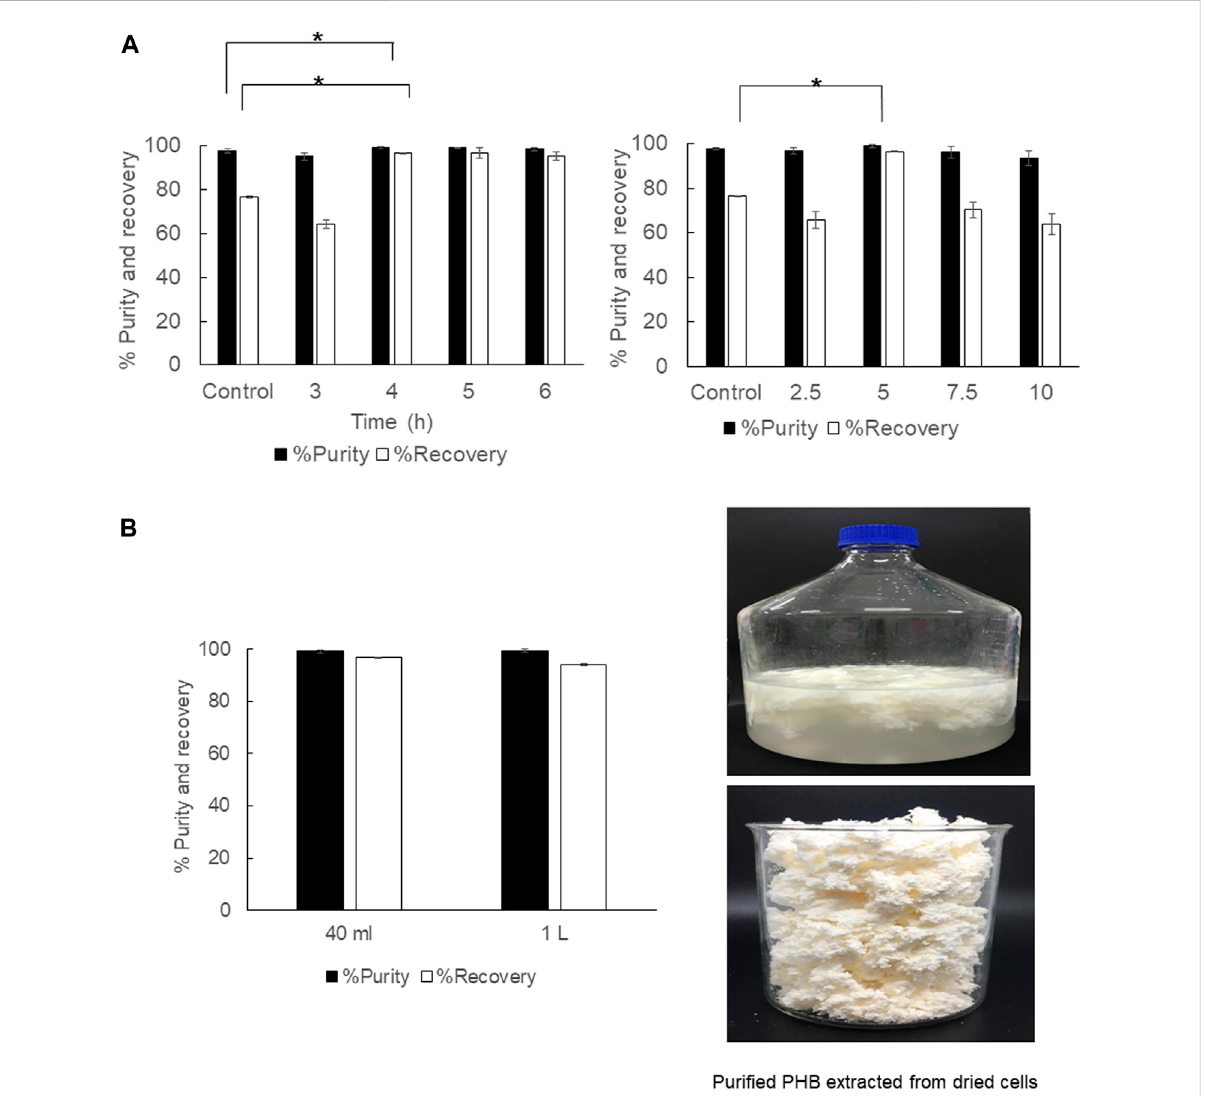
FIGURE 5 (A) TimecoursesofPHBextractionusingashakingwaterbathfromdriedcellsat150rpmandtheeffectofthesolid-to-solventratiovariedfrom 2.5, 5, 7.5, and 10% (w/v). (B) The effect of direct scale-up from 40 ml to 1000 ml on the % purity and % recovery and the characteristics of puri fi ed PHB extracted from dried cells. All the data are representative of the results of three independent experiments and are expressed as the mean values ± standard deviations (SDs). The asterisk indicates a signi fi cant difference ( p <